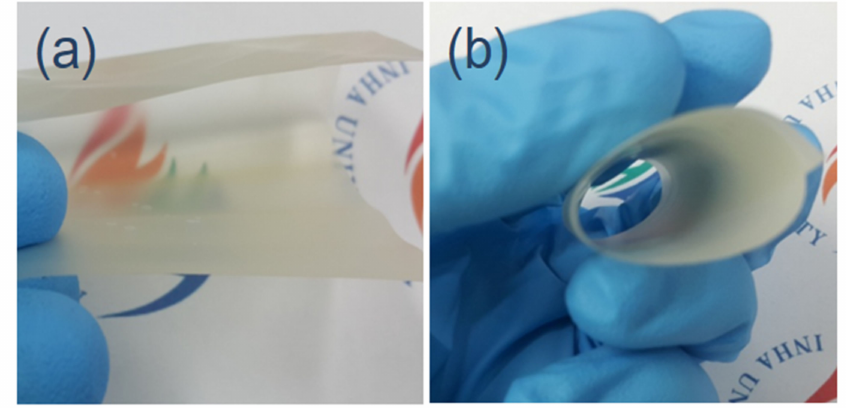
Figure 5. Flexibility of ChNF–CNF composite by: ( a ) bending; and ( b )